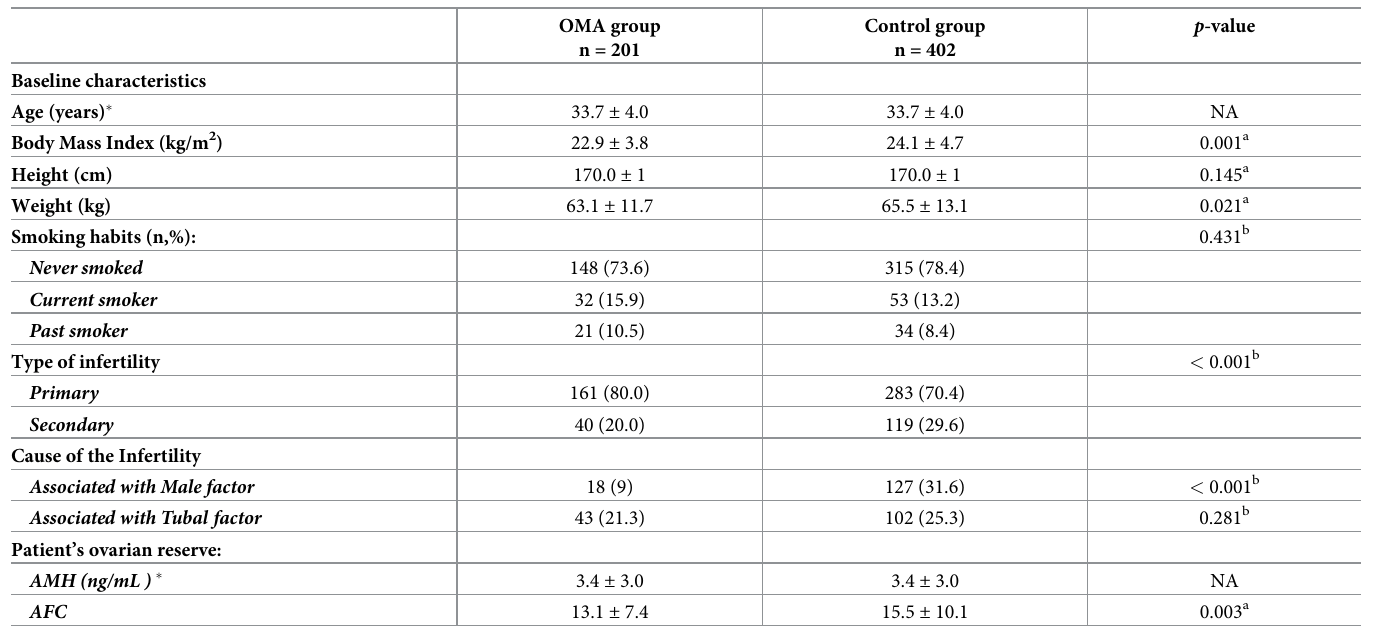
Table 1. Baseline characteristics for the OMA group and the control